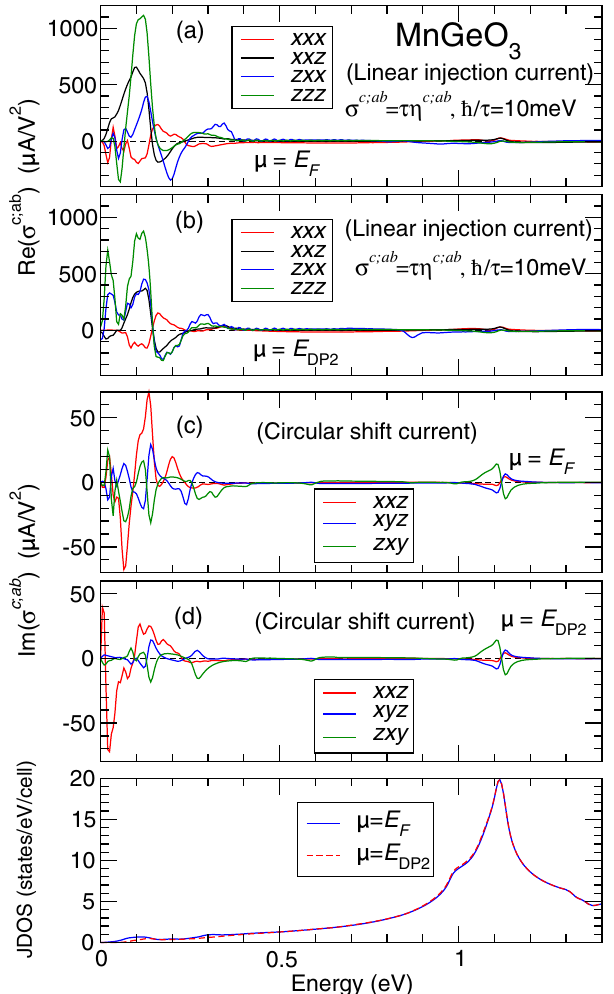
FIG. 4. Conductivity tensors and JDOS of antiferromagnetic MnGeO 3 . (a,b) Linear injection. (c,d) Circular shift. In panels (b) and (d), the conductivities are calculated with the Fermi level set to the DP 2 Dirac point energy (see Fig. 5). (e) JDOS as a function of photon